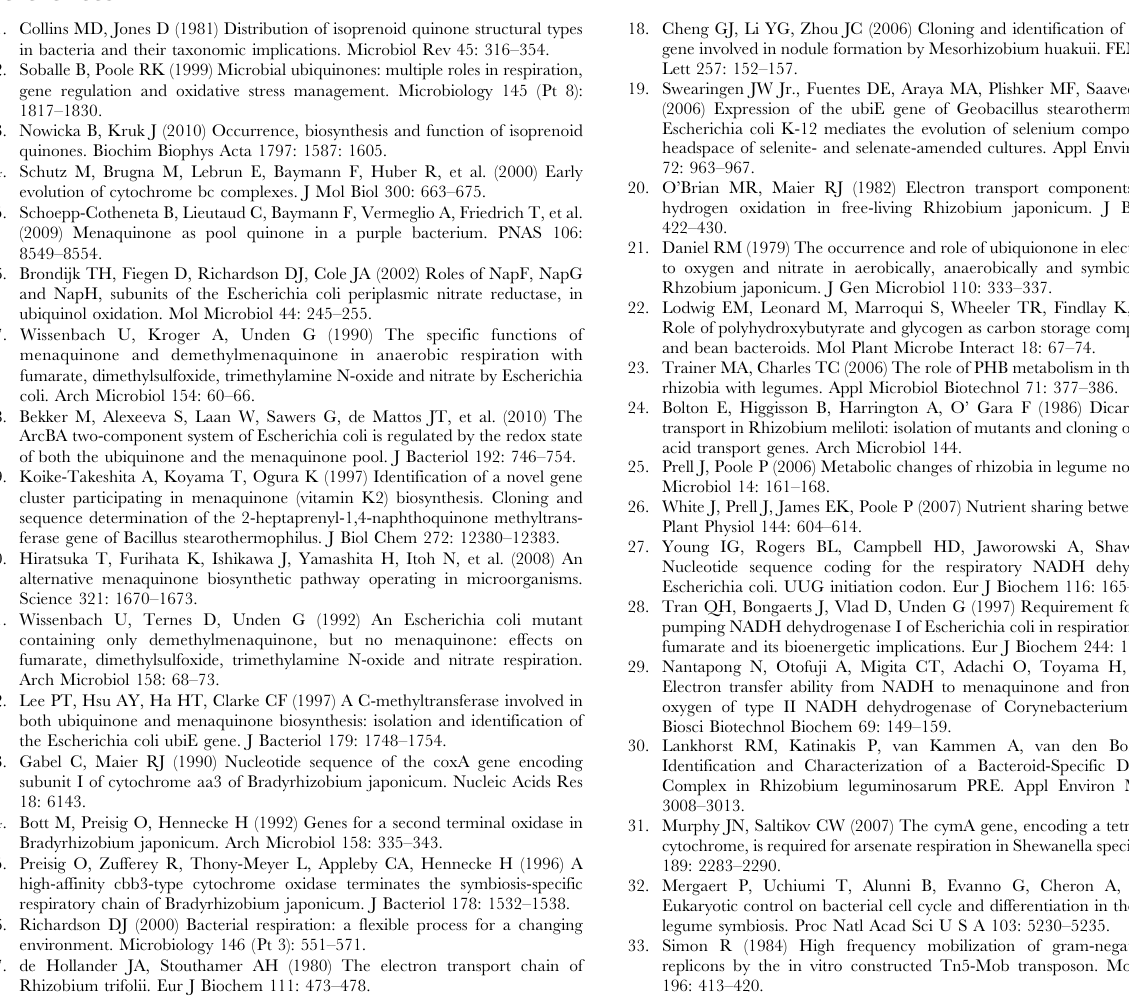
Figure S2 Homology tree of DmtH homologs. The homology tree was constructed using MEGA5.04 software (Tamura K, 2011). The scale bar indicates 10% substitutions per site. (TIF) Figure S3 Southern blot analysis of dmtH gene in different Rhizobium genomes. The total genomic DNA of tested strains were digested for at least 3 h with 5-10 U of restriction enzyme PstI and BamHI per m g of DNA. Digested genomes were subjected to electrophoresis and transfer to nylon membranes, then hybridized to a 32 P-labeled probe. The tested strains was Agrobacterium tumefaciense IAMI 3129 (A. tum), Sinorhizobium medicae USDA 1037 (S. med), Sinorhizobium meliloti USDA 2011 (S. mel), Sinorhizobium saheli LMG 7837 (S. sah), Rhizobium leguminosarum LRP 5045 (R. leg), Sinorhizobium fredii HN01 (S. fre), Mesorhizobium loti 541 (M. lot), Sinorhizobium arboris HAMBI 1552(S. arb), Azorhizobium caulinodans USDA 4892 (A. cau). (A) the electrophoresis map of Bam HI-digested genomic DNA. (B) the electrophoresis map of Pst I-digested genomic DNA. (C) Bam HI-digested DNA hybridised with probe dmtH . (D) Pst I- digested DNA hybridised with probe dmtH. The Southern blot shows that dmtH gene is present in R. leguminosarum LRP 5045 and M. loti 541. (TIF)